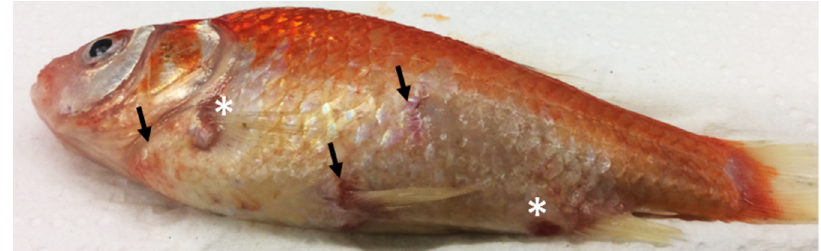
Figure 3. Clinical signs of goldfish chinook salmon bafinivirus Cefas-W054 observed in an intraperitoneally injected goldfish, consisting of petechial haemorrhages in the skin and the base of the fins (arrows) and skin ulcerations (asterisks).